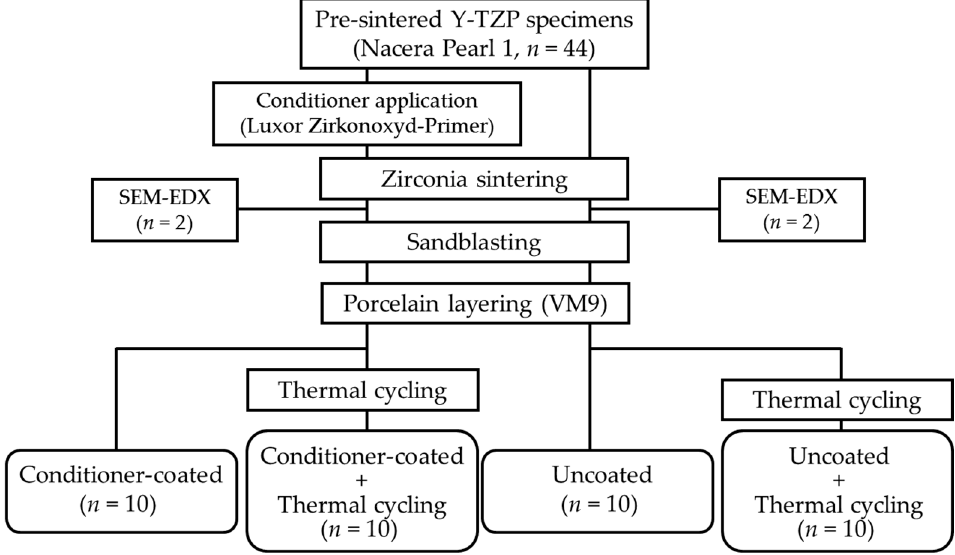
Figure 1. Experimental groups in this study. Table 1. Zirconia sintering and porcelain firing schedules.